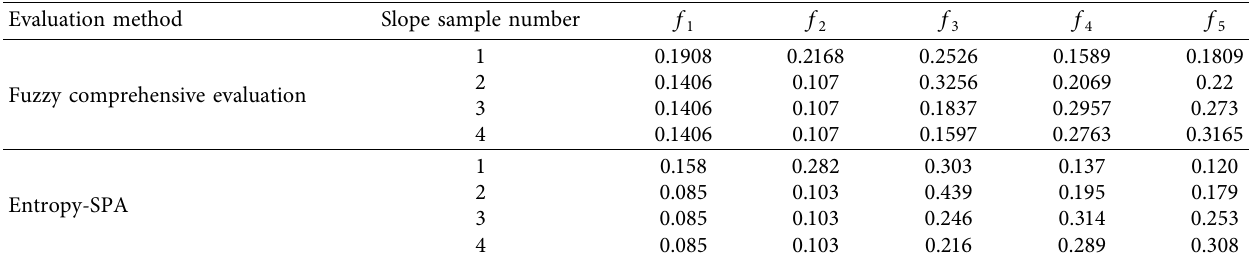
Table 10: Evaluation results of fuzzy comprehensive evaluation method and entropy-SPA method.